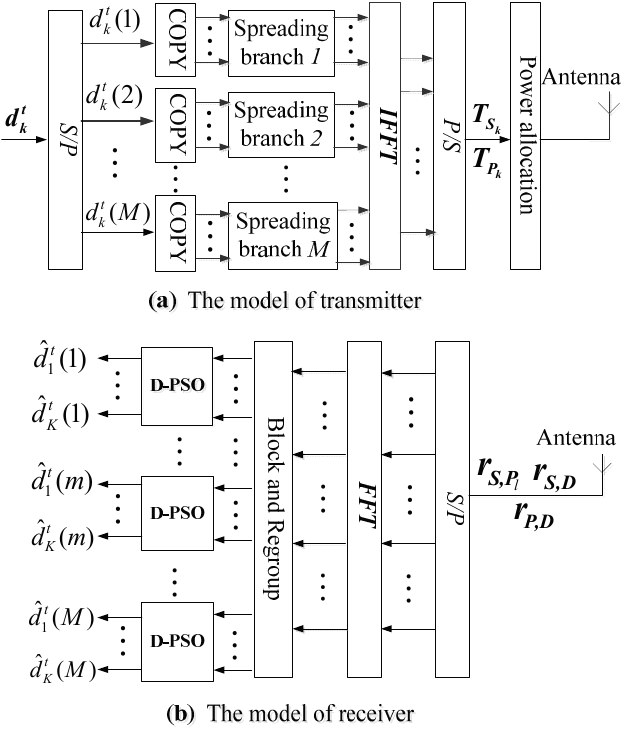
Figure 2. Proposed transmitter and receiver based on